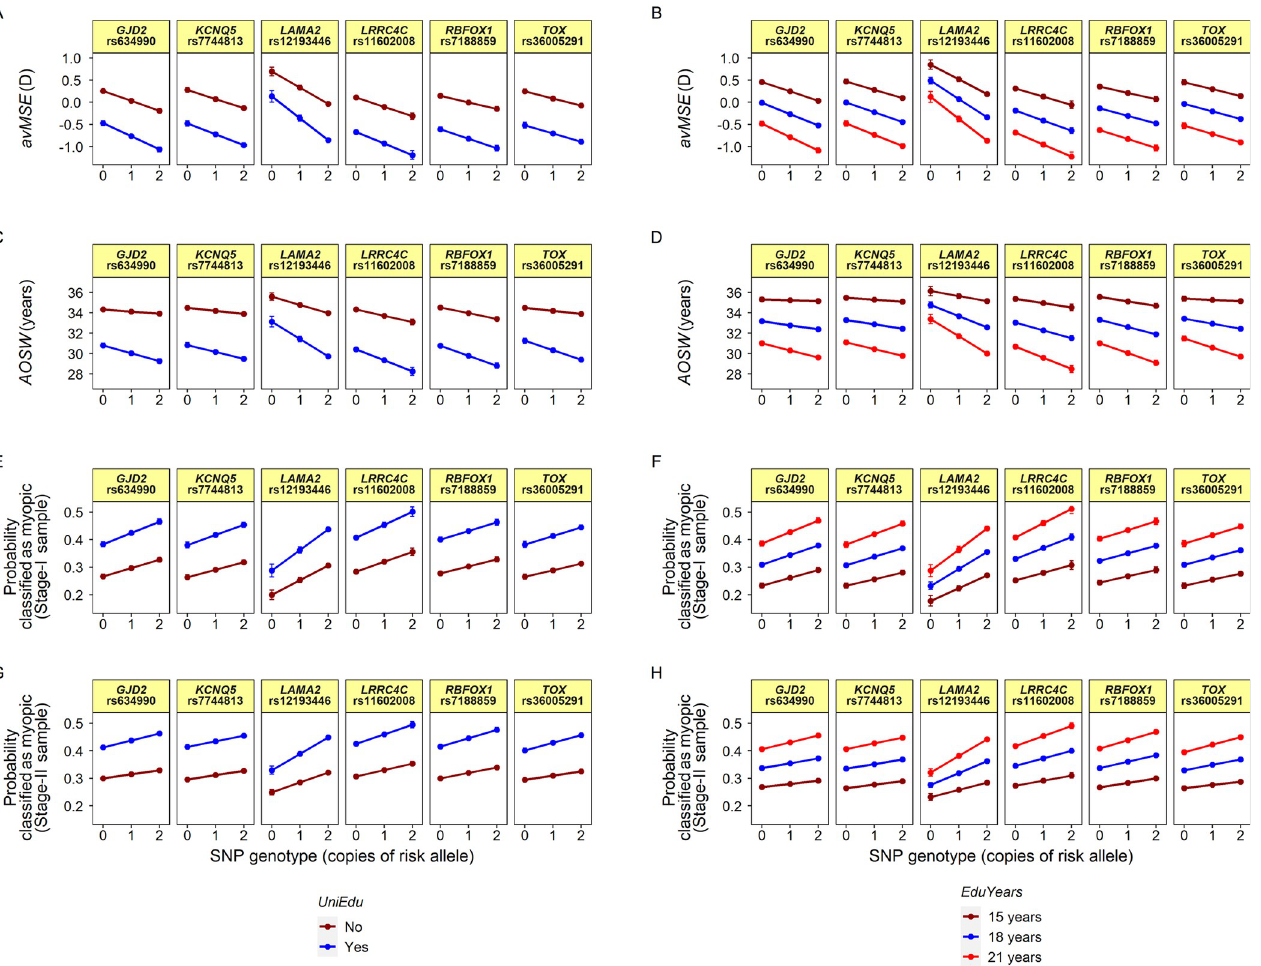
Fig 2. Genetic variants with evidence of genotype-by-education interactions. Results are presented for a range of outcome traits, for tests of the interaction between SNP genotype and education level. Education level is coded as either UniEdu (panels A, C, E & G) or EduYears (panels B, D, F & H). Panels A & B: Linear regression analysis for the outcome avMSE in the Stage-I sample. Panels C & D: Linear regression analysis for the outcome age-of-onset of spectacle wear ( AOSW ) in the Stage-II sample. Panels E & F: Logistic regression analysis for the outcome Myopic (calculated based on avMSE ) in the Stage-I sample. Panels G & H: Logistic regression analysis for the outcome Myopic (calculated based on AOSW ) in the Stage-II sample. The nearest gene to the SNP is indicated above the SNP rsID. Error bars are 95% confidence intervals. The SNP risk allele was defined as the myopia-predisposing allele in a marginal effects